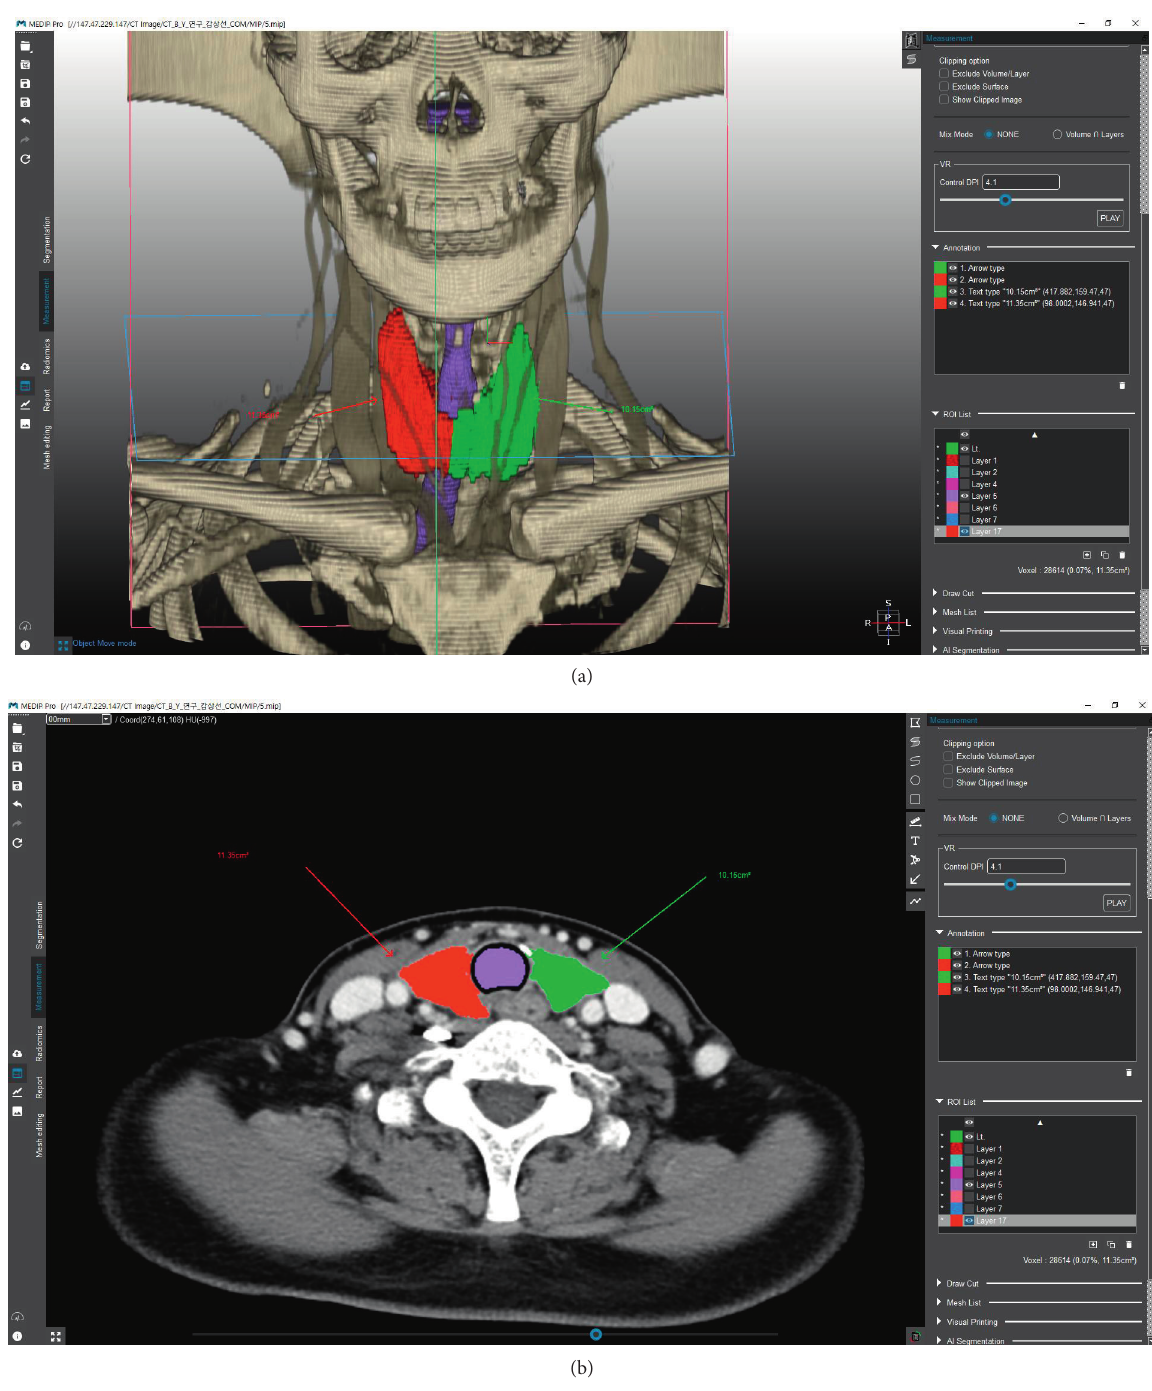
Figure 3: Representative image of the volumetric extraction of the thyroid. (a) 3D image shows a volumetric segmentation of the right (green) and left (red) thyroid glands using a Draw-Cut function. (b) Axial image shows the results of segmentation. The 3D segmentation volumes were measured using MEDIP